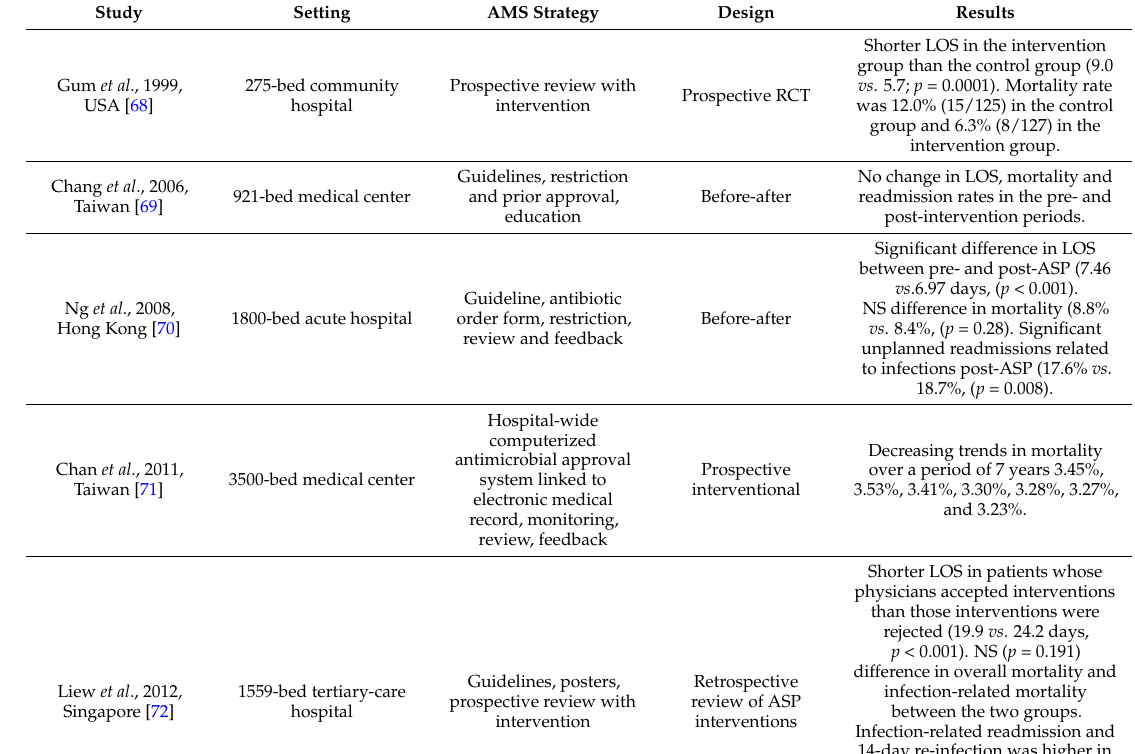
Table 4. Impact of ASP on patient